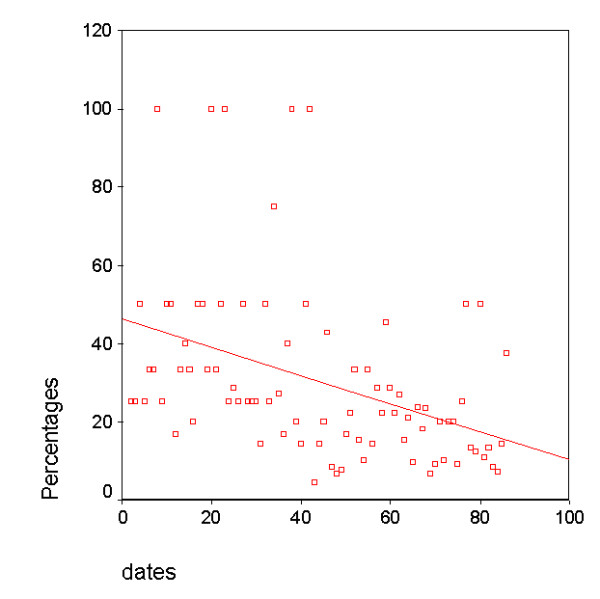
Regression of the percentage of positive microbiological test results 100 days before the end of the Olympics, r = 0.397, p < 0.001.